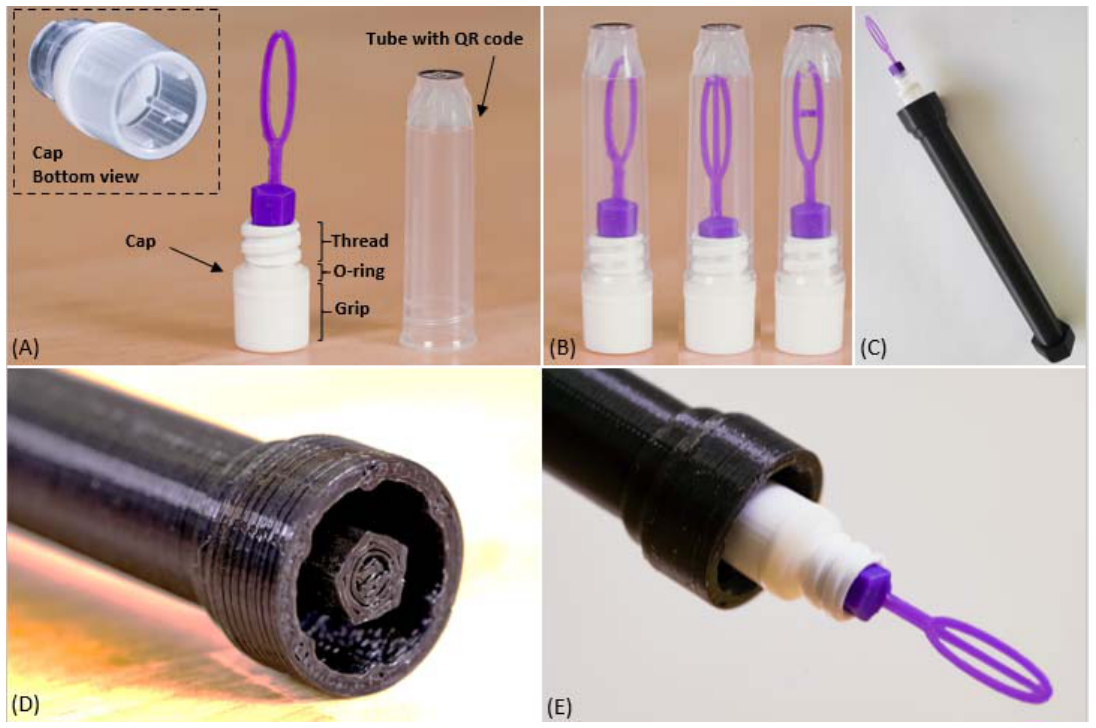
Figure 1. Vitrification Device for Cryo-Vials (VDCV) fabricated by 3D printing. ( A ) A 0.5-mL Nunc™ Bank-It™ cryogenic storage vial comprises a cap and a tube. ( B ) Vitrification components with three different configurations (from left to right): open loop, axial support, and transverse support. A handling component ( C ) with structures ( D ) to fit 0.5-mL Bank-It™ cryogenic storage vials ( E ).